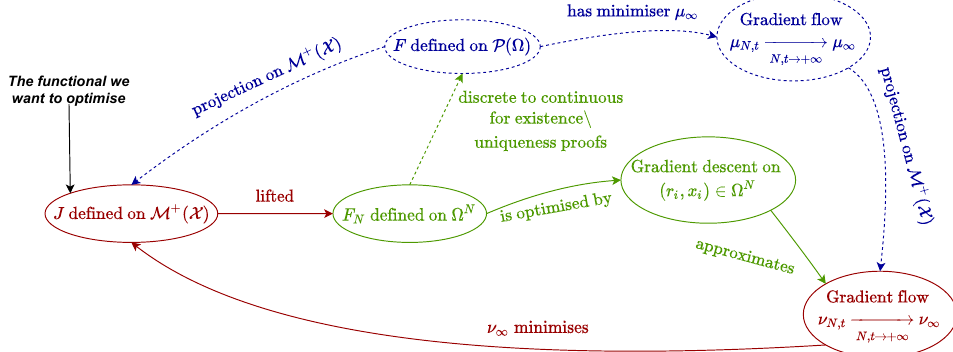
Figure 6. Digest of the important quantities mentioned in [3,23]: red refers to M + ( X ) quantities, green to Ω N def. = ( R + × X ) and blue to the Wasserstein space P 2 ( Ω ) and theoretical results. Dashed lines correspond to the theoretical section, and continuous lines indicate the numerical